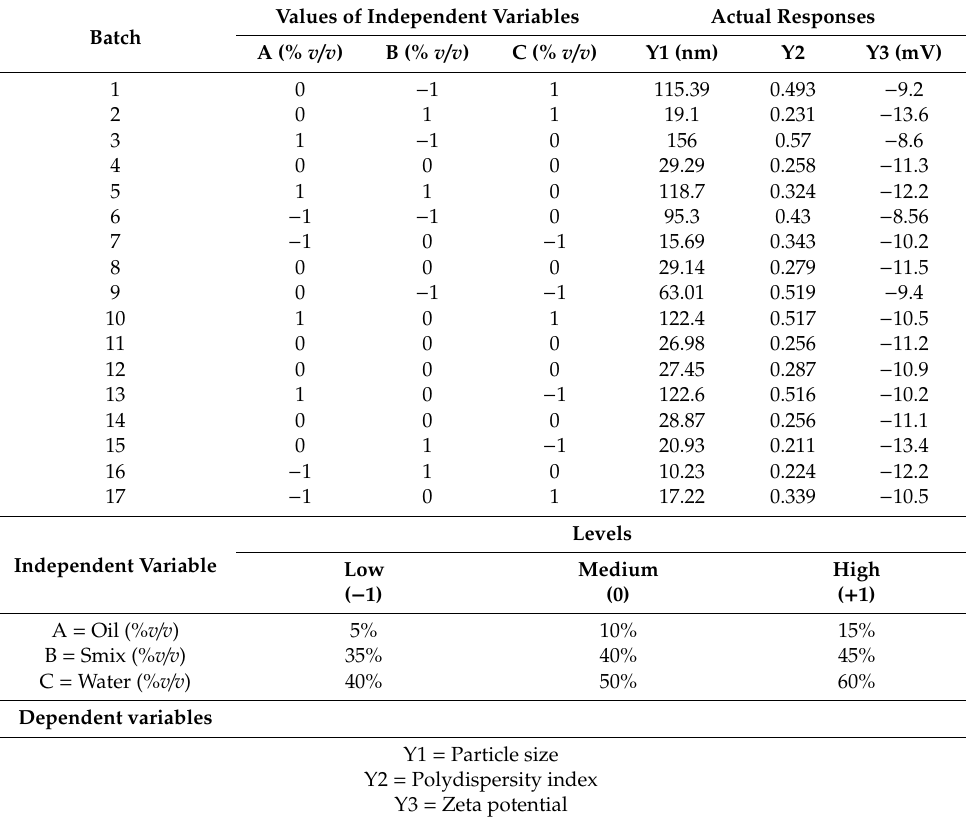
Table 1. Box–Behnken statistical design: The generated experimental runs along with independent variables at their three levels and experimental dependent variables for blank nanoemulsions